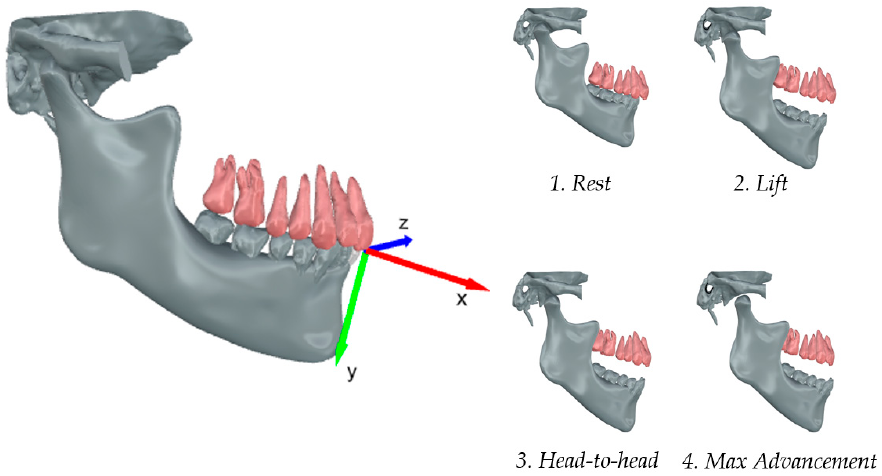
translation is displayed as four sequential configurations: Rest (1), Lift (2), Head-to-head (3), and Max advancement (4).